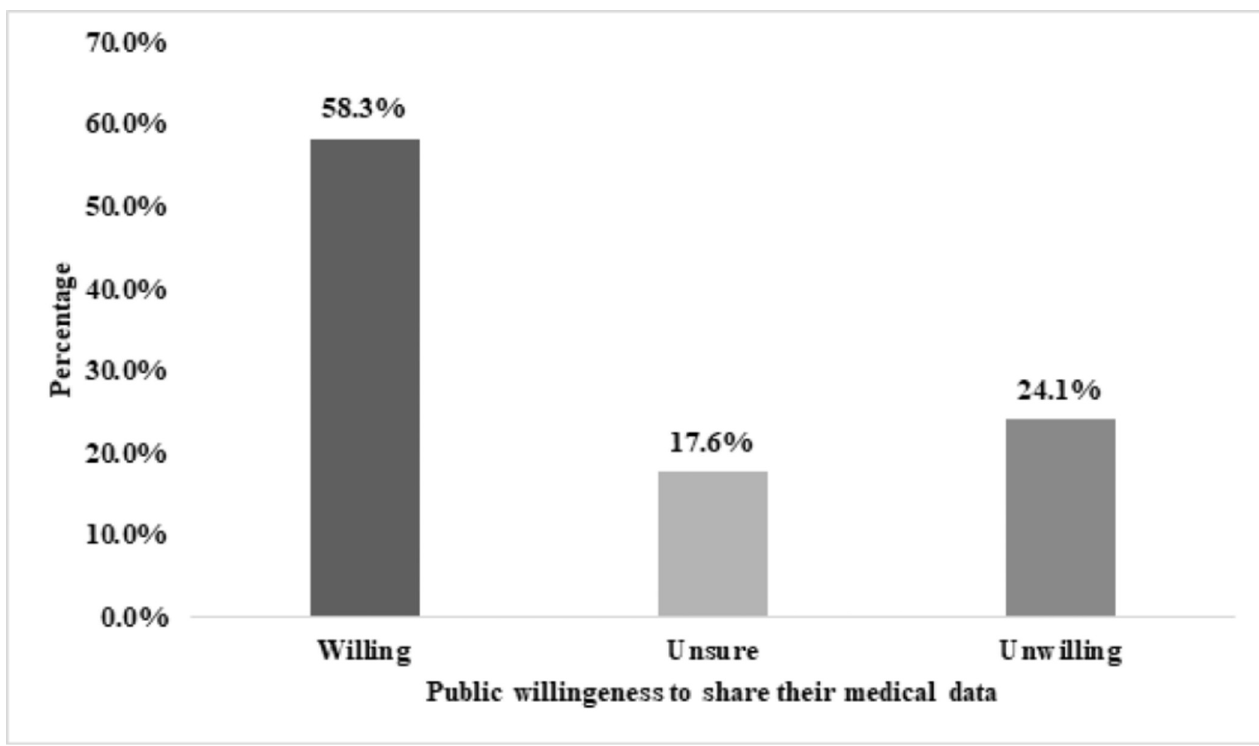
Fig 1. Public willingness to share their medical data (n = 1194).